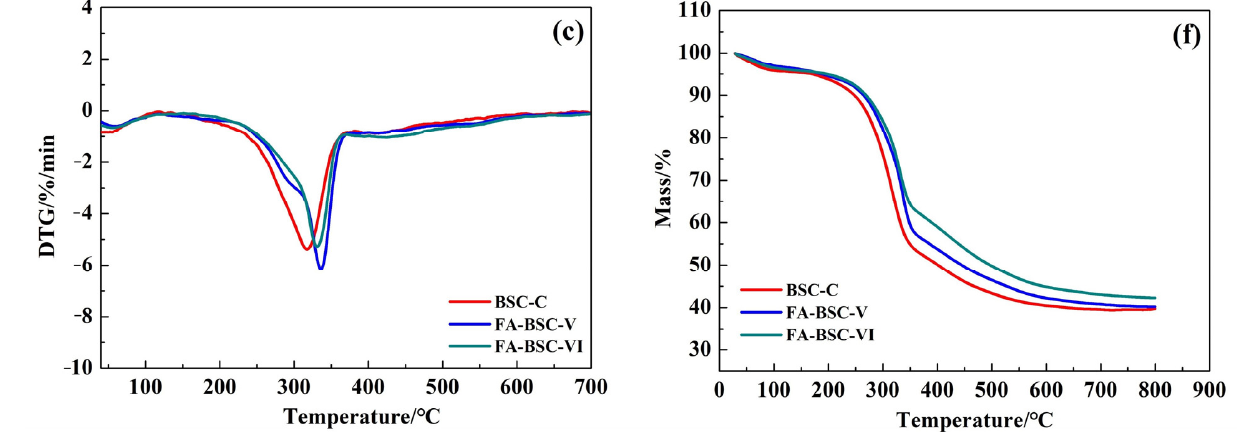
Figure 7. Thermogravimetric analysis of untreated BSCs and furfurylated BSCs. ( a , d ) from BSC-C, FA-BSC-I and FA-BSC-II; ( b , e ) from BSC-C, FA-BSC-III and FA-BSC-IV; ( c , f ) from BSC-C, FA-BSC-V and FA-BSC-VI.